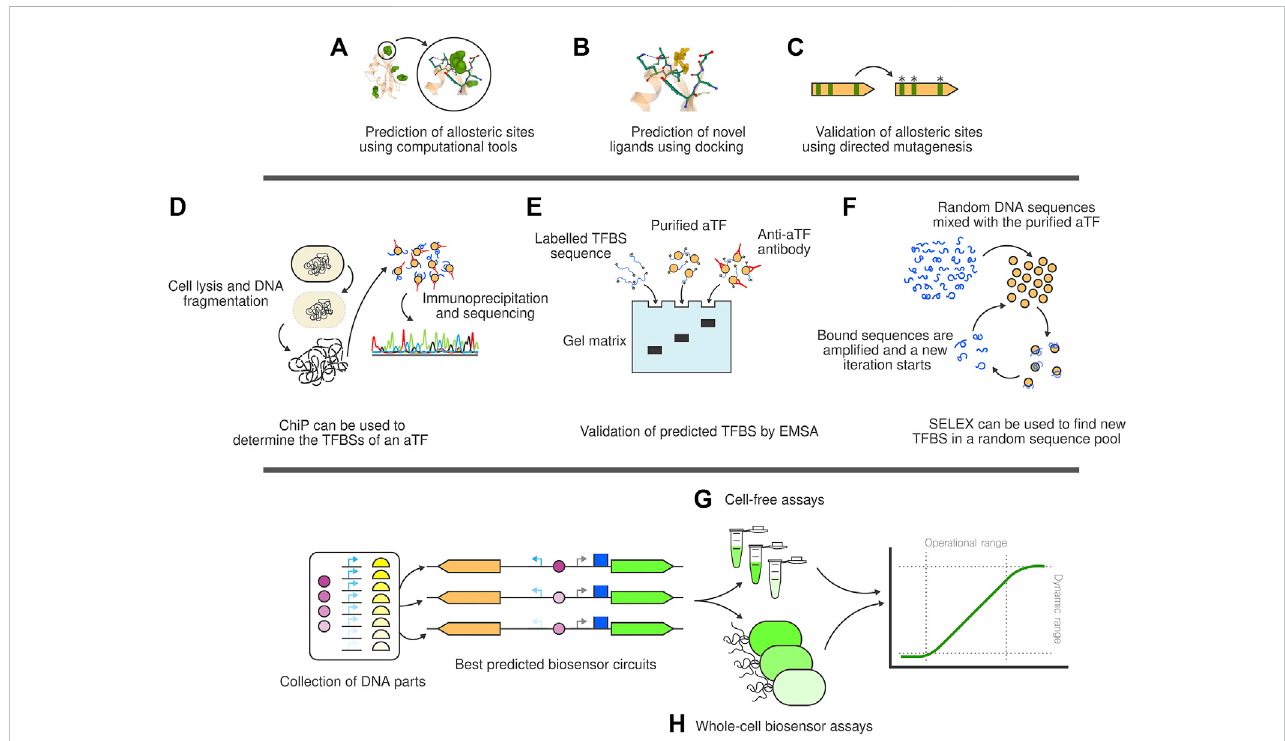
FIGURE 2 The full stack biosensor development toolbox. (A) Computational tools can be used to determine the allosteric pockets of interaction between ligands and aTF. (B) Using these pockets as reference, docking computations can be carried out to assess the af fi nity of the aTF towards a library of putative ligand compounds. (C) Theallostericsitecomputationcanbevalidatedusingdirectedmutagenesistoevaluatechangesinaf fi nityorspeci fi city. (D) ChIPtechnology allowsresearcherstodeterminetheTFBSsofanewlydiscoveredaTF. (E) Similarly,EMSAcanbeusedtoindividuallyvalidatesingleTFBS. (F) SELEXcanbe used to arti fi cially obtain new TFBS to the aTF. (G) Cell-free assays are a quick prototyping technology to test biosensor circuits once assembled. (H) Whole- cell biosensor experiments allow the characterisation of the biosensor circuit in conditions closer to in vivo